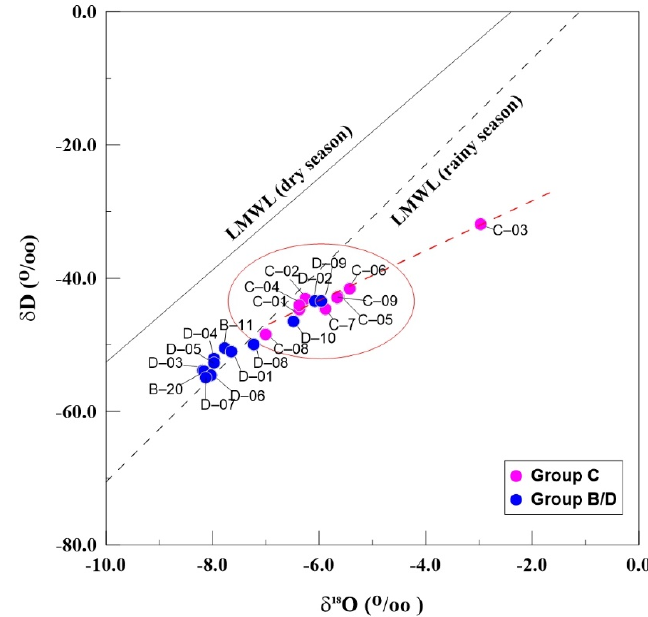
Figure 7. Isotopic analysis results for groundwater samples from the first survey in July 2019. Dotted red line indicates evaporation line, and wells in elliptical region generally have large seasonal change in groundwater quality.